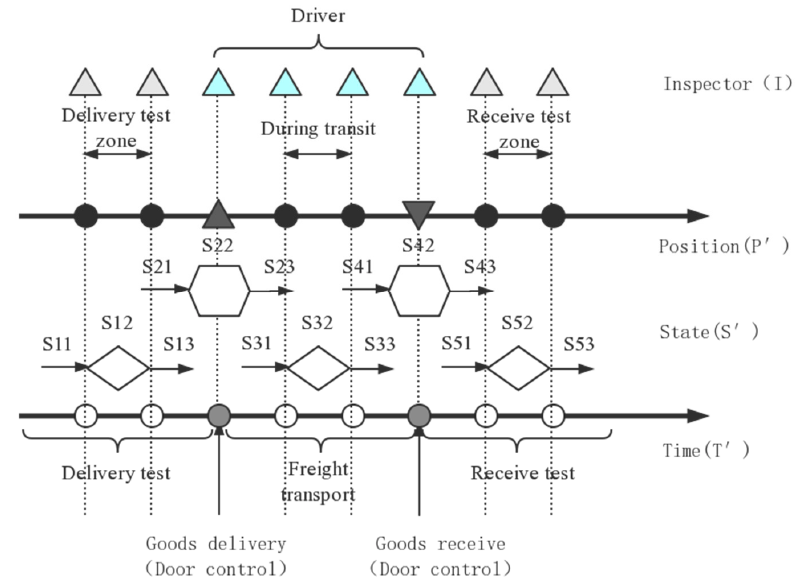
Figure 6. RFID tracking configuration model based on the transportation process of the inbound and outbound plants.